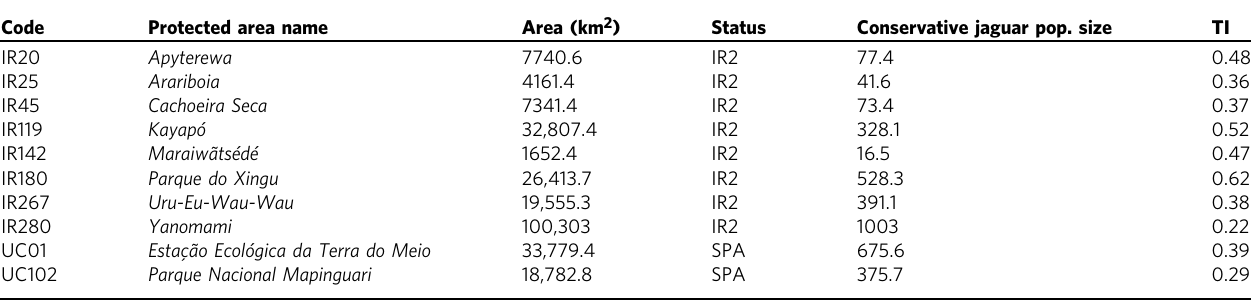
Table 1 Protected area codes, names, size (km 2 ) and legal status of high-priority reserves (i.e., top-10) for jaguar conservation across the Brazilian Amazon (see also Fig. 4 and Supplementary Data